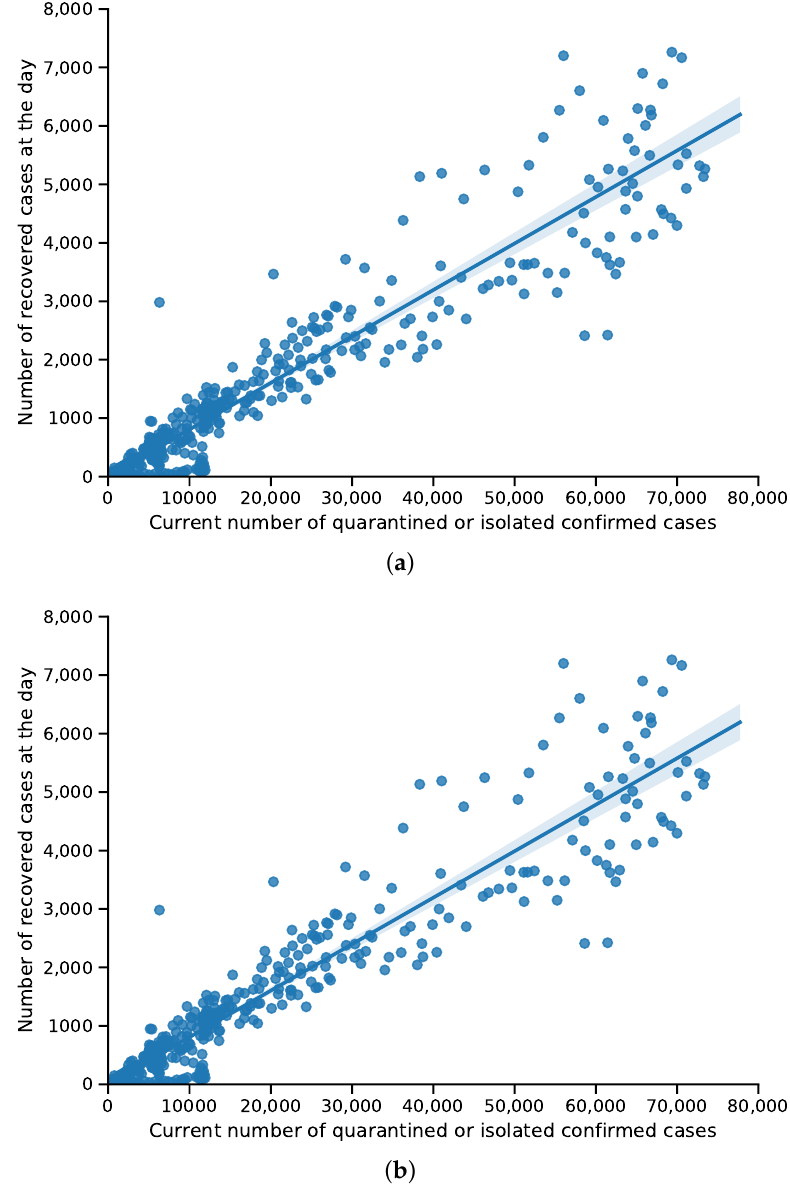
Figure 2. Data fitting for the recovery rate and death rate of COVID-19 in Japan. ( a ) Data fitting for the recovery rate. ( b ) Data fitting for the death